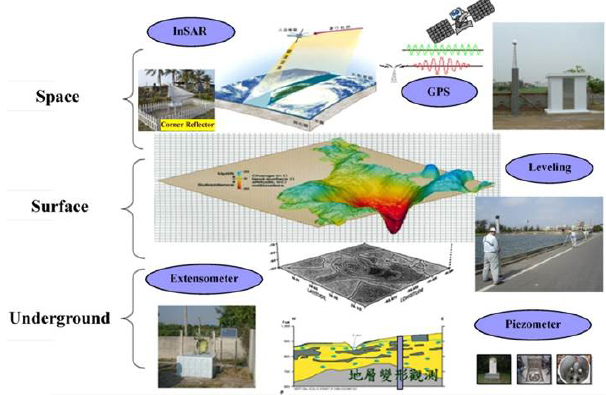
Figure 3. Sample pictures of Multi-sensor monitoring system.